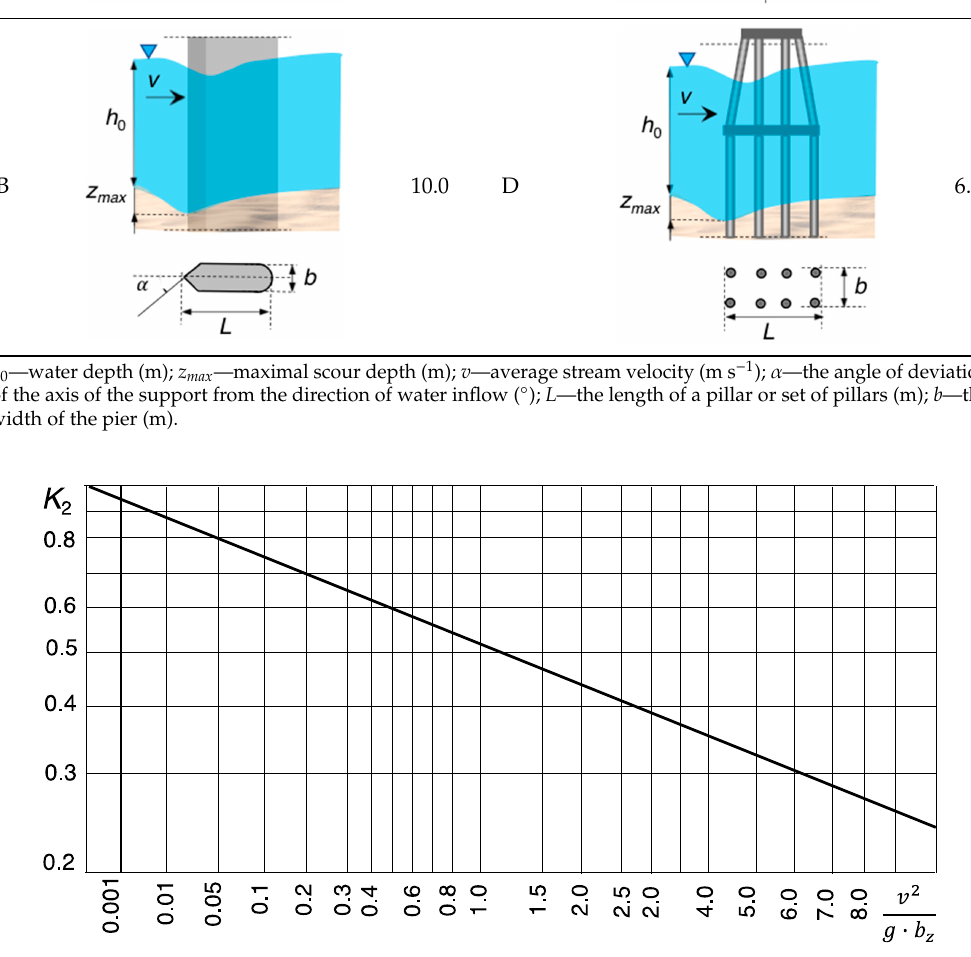
Figure 8. Coefficient K 2 (in accordance with Journal of Laws of 2000 No. 63, item 735 [11]). Figure 8. Coe ffi cient K 2 (in accordance with Journal of Laws of 2000 No. 63, item 735